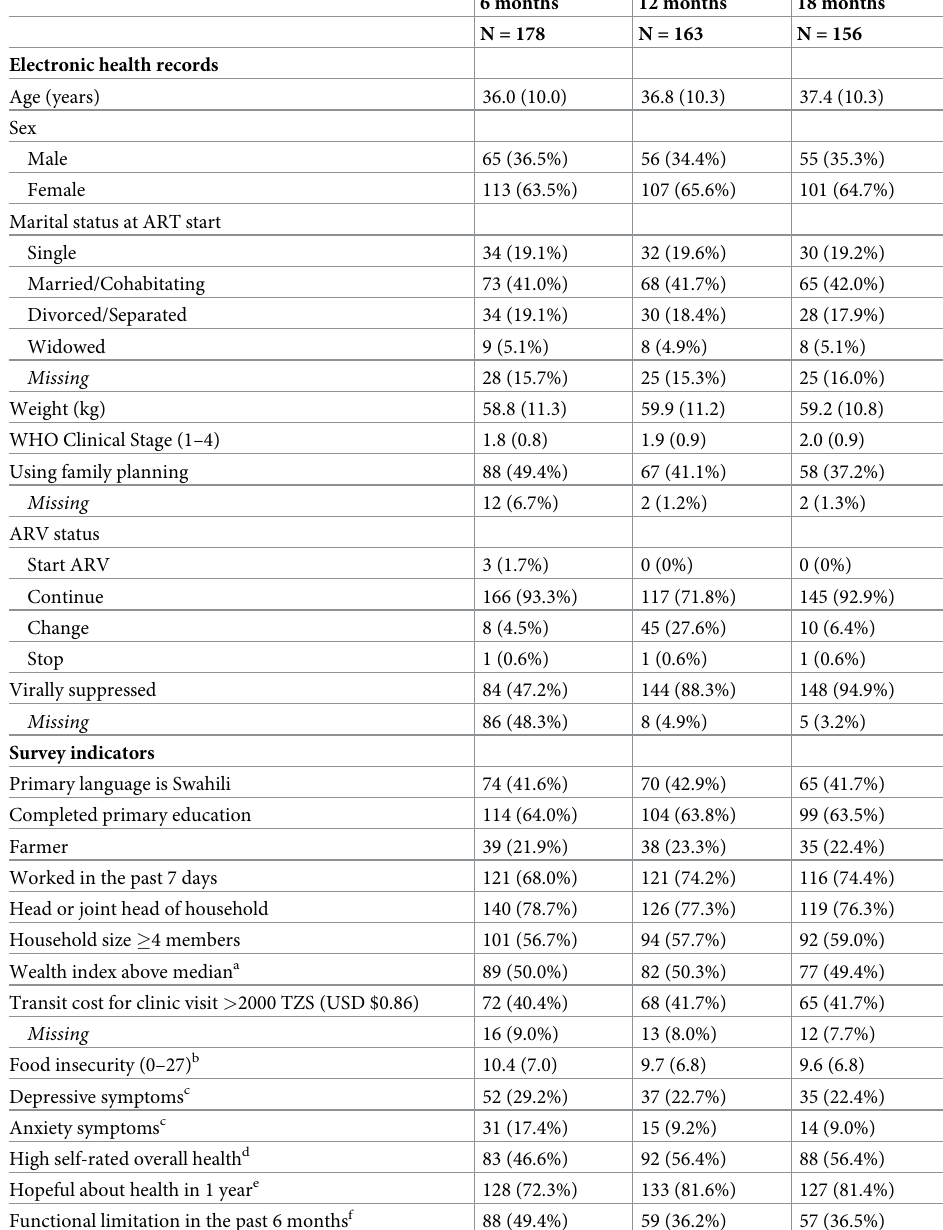
Table 1. Participant characteristics over time, HIV treatment initiates in